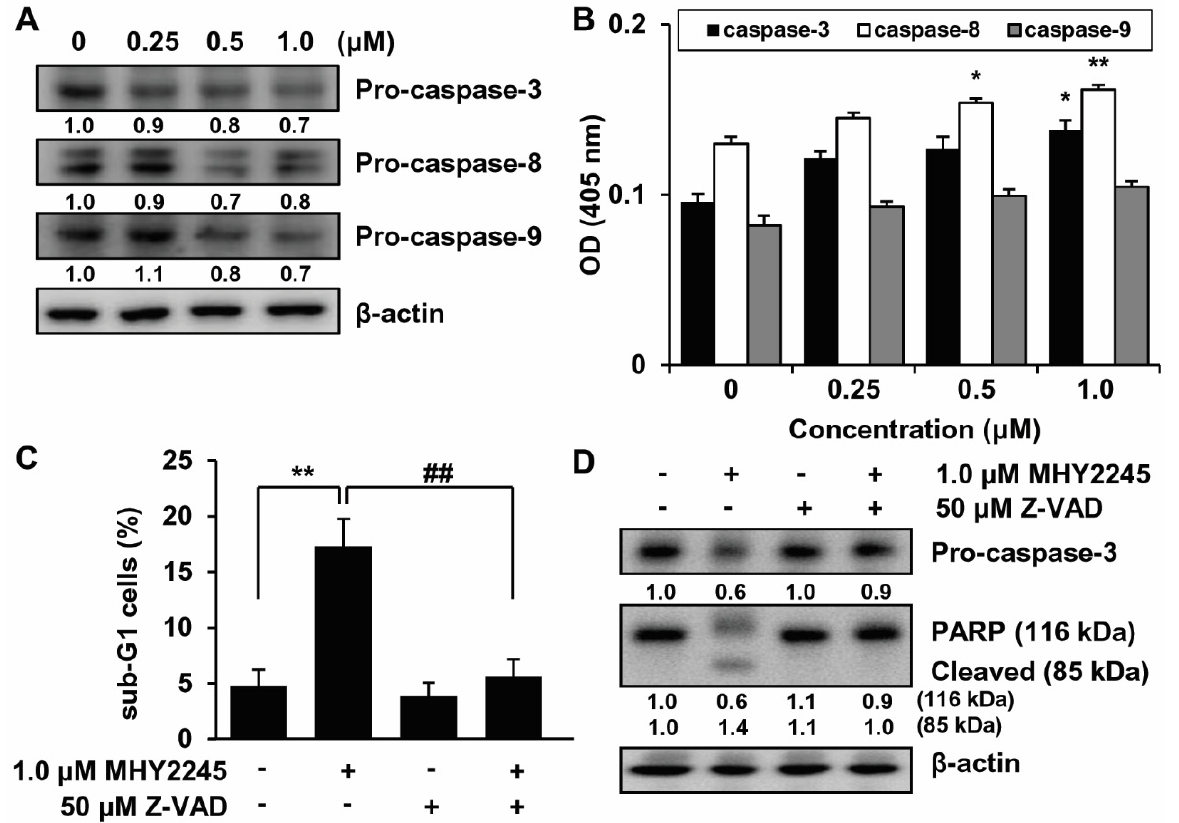
Figure 7. Role of caspases in MHY2245-induced apoptosis. ( A ) The expression of pro-caspases-3, -8, and -9 in MHY2245-treated cells was detected via Western blot analysis. β -actin was used as a loading control. Results from three independent experiments are shown. ( B ) Cell lysates from cells treated with MHY2245 for 24 h were assayed to detect caspase-3, -8, and -9 activities using DEVD-pNA, IETD-pNA, and LEHD-pNA as respective substrates at 37 ◦ C for 1 h. The released fluorescent products were measured. Results are expressed as mean ± SD of three independent experiments. * p < 0.05 and ** p < 0.01 compared with that in vehicle-treated control cells. ( C ) The presence of cells with sub-G1 DNA content following treatment with MHY2245, indicative of the onset of apoptosis, was detected via flow cytometry. ** p < 0.01 compared with that in vehicle-treated control cells. ## p < 0.01 compared with that in 1.0 µ M MHY2245-treated cells. ( D ) Western blot analysis of PARP and pro-caspase-3 in the total lysates of cells treated with 50 µ M Z-VAD-FMK (Z-VAD) and 1.0 µ M MHY2245. β -actin was used as a loading control. Representative results from three independent experiments are